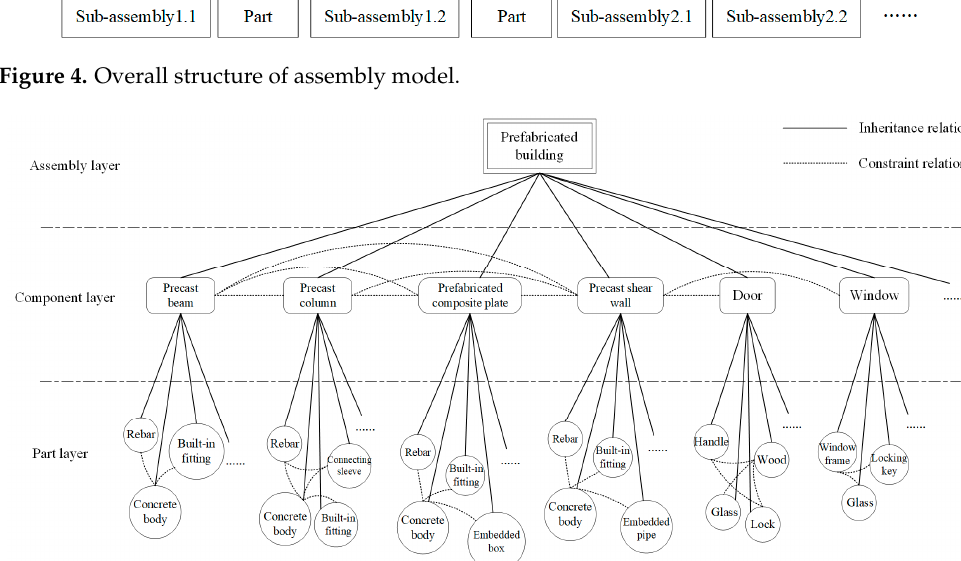
Figure 5. Hierarchical distribution structure of assembly model.